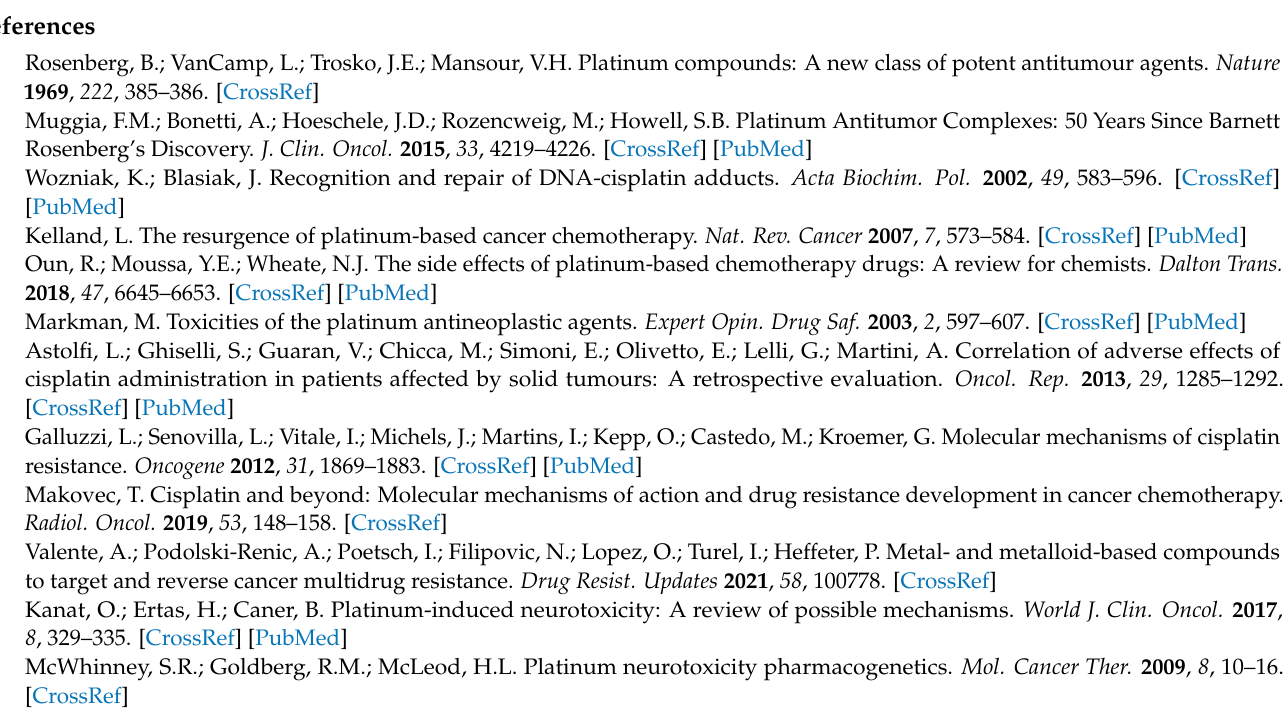
spectrum of compound L , Figure S3: High resolution mass spectrum of compound L , Figure S4: FTIR spectrum of compound MnL , Figure S5: ESI mass spectrum of compound MnL , Figure S6: FTIR spectrum of compound FeL , Figure S7: High resolution mass spectrum of compound FeL , Figure S8: FTIR spectrum of compound CoL , Figure S9: High resolution mass spectrum of compound CoL , Figure S10: 1 H NMR spectrum of compound NiL , Figure S11: FTIR spectrum of compound NiL , Figure S12: ESI mass spectrum of compound NiL , Figure S13: FTIR spectrum of compound CuL , Figure S14: High resolution mass spectrum of compound CuL , Figure S15: 1 H NMR spectrum of compound ZnL , Figure S16: FTIR spectrum of compound ZnL , Figure S17: ESI mass spectrum of compound ZnL , Figure S18: Molecular docking of L , MnL , and BTA with DNA, Figure S19: Molecular docking of L , MnL , and BTA with